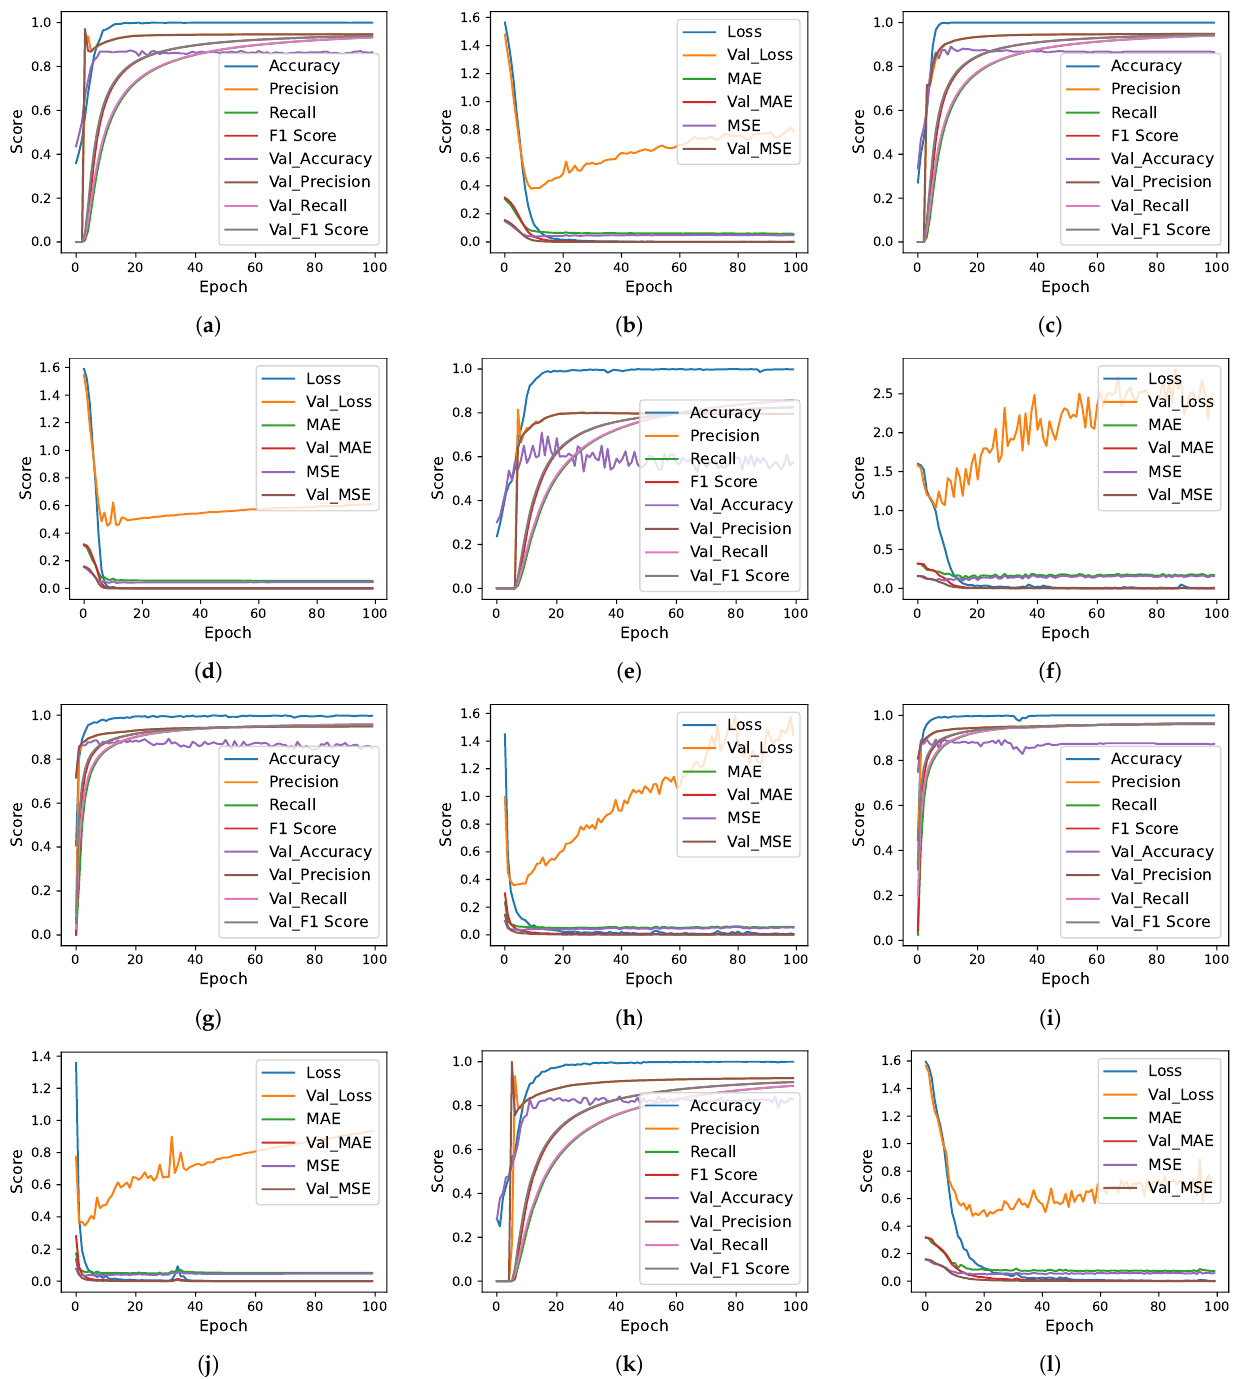
Figure 7. Deep learning models per epochs evaluation scores using BiDFE and BFE. ( a ) CNN accuracy using BFE, ( b ) CNN loss using BFE, ( c ) CNN-LSTM accuracy using BFE, ( d ) CNN-LSTM loss using BFE, ( e ) LSTM accuracy using BFE, ( f ) LSTM loss using BFE, ( g ) CNN accuracy using BiDFE, ( h ) CNN loss using BiDFE, ( i ) CNN-LSTM accuracy using BiDFE, ( j ) CNN-LSTM loss using BiDFE, ( k ) LSTM accuracy using BiDFE and ( l ) LSTM loss using